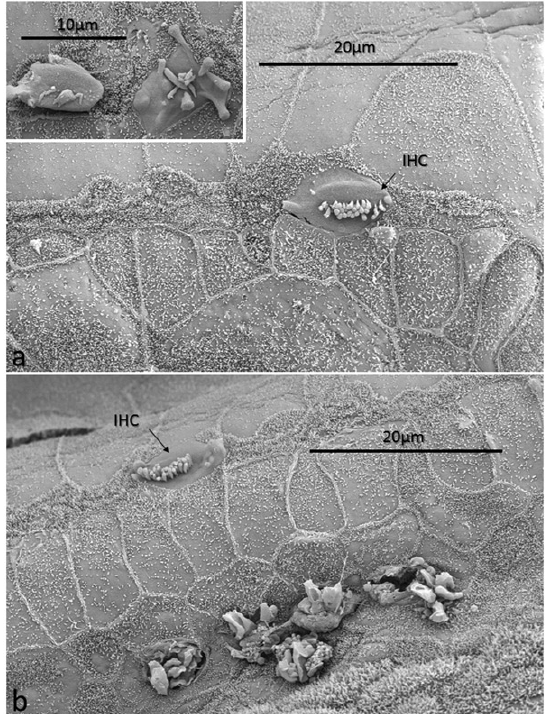
Figure 6. FESEM of the ‘ hook ’ region of the human cochlea. This region was generally devoid of hair cells. Image a: There is a solitary IHC with short stereo- cilia. Scarring of the reticular lamina is present. The inset shows two degener- ated IHCs. Image b: A solitary IHC can be observed. The inner pillar heads appear preserved, whereas degenerated OHCs are observed below. Reparative processes or sIHCs are not apparent (patient 1).